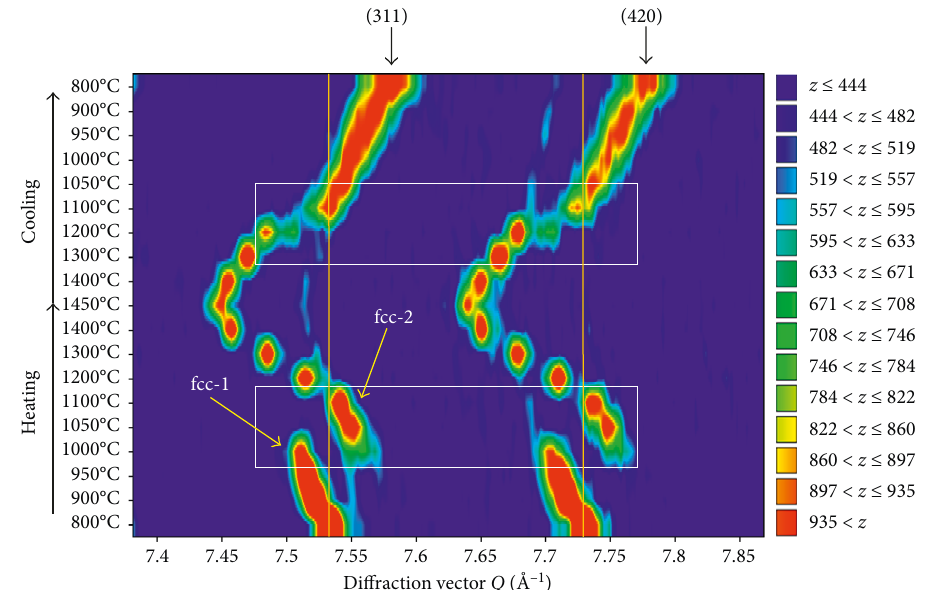
Figure 1: Intensity colour map of fcc reflections (331) and (420) as a function of temperature. Coexistence of two fcc phases during heating and cooling is highlighted. Low-intensity peaks crossing the whole temperature range (light blue) come from the Al 2 O 3 sample holder parasitic